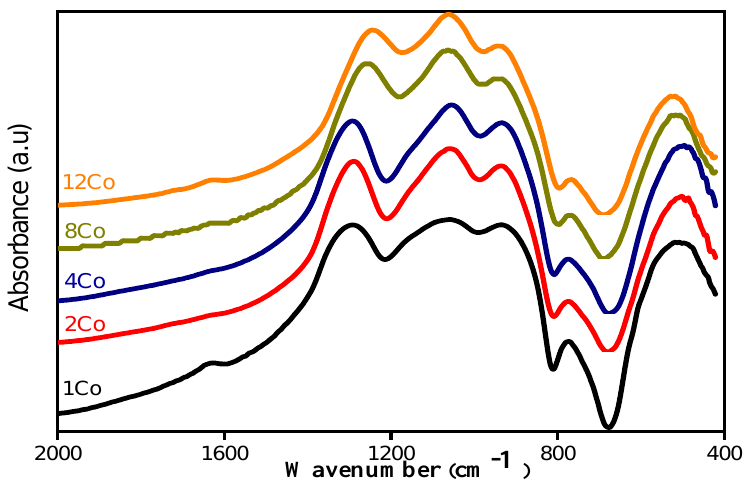
12 mol%). Figure 3. FTIR spectra of the glasses (50−x)P 2 O 5 –20B 2 O 3 –5Al 2 O 3 –25Na 2 O–xCoO, (x = 1, 2, 4, 8 and 12 mol%).